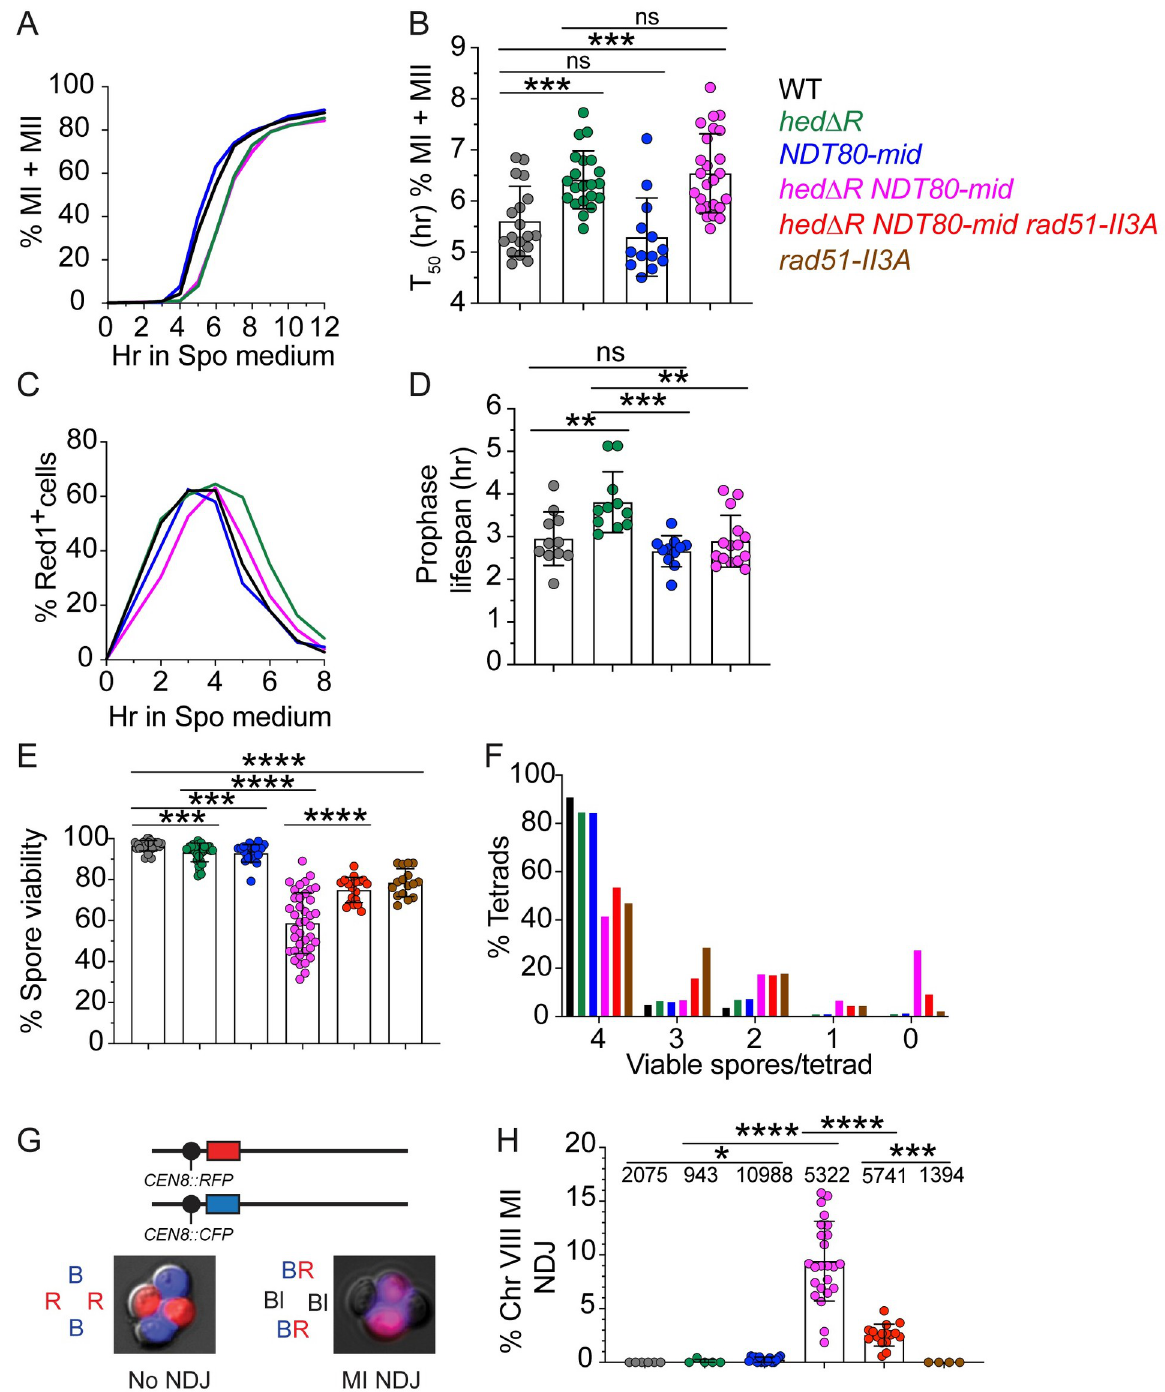
Fig 3. Elimination of the MRC rescues the prophase I delay due to constitutive Rad51 activation, while decreasing spore viability and increasing MI nondisjunction. (A) Meiotic progression. Timecourses of the following diploids were analyzed for meiotic progression as described in Fig 1: WT, hed Δ R , NDT80-mid (NH2495 or NH2634 RCEN) ( n = 13) and hed Δ R NDT80-mid (NH2505 or NH2610 RCEN) ( n = 25). The average of all replicates is plotted. (B) Comparison of T 50 values of timecourses shown in Panel A. (C) Prophase I progression. A subset of timecourses in panel A ( NDT80-mid , n = 11, hed Δ R NDT80-mid , n = 15) were analyzed for prophase I progression as described in Fig 1. WT and hed Δ R data are from Fig 1. The average of all replicates is plotted. (D) Prophase I lifespan for each sporulation culture in Panel C was calculated as described in Fig 1. (E) Spore viability. Sporulated cells from both liquid and solid sporulation media were dissected to determine the percent of